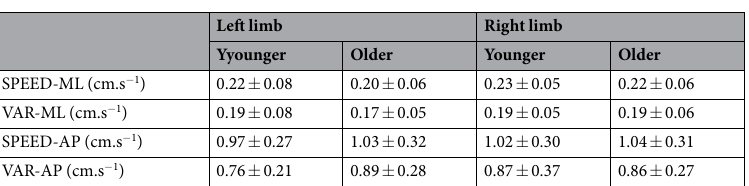
Table 2. Mean ± SD average center of pressure speed (SPEED) and center of pressure speed variability (VAR) in the medial-lateral (ML) and anterior-posterior (AP) directions for the younger and older